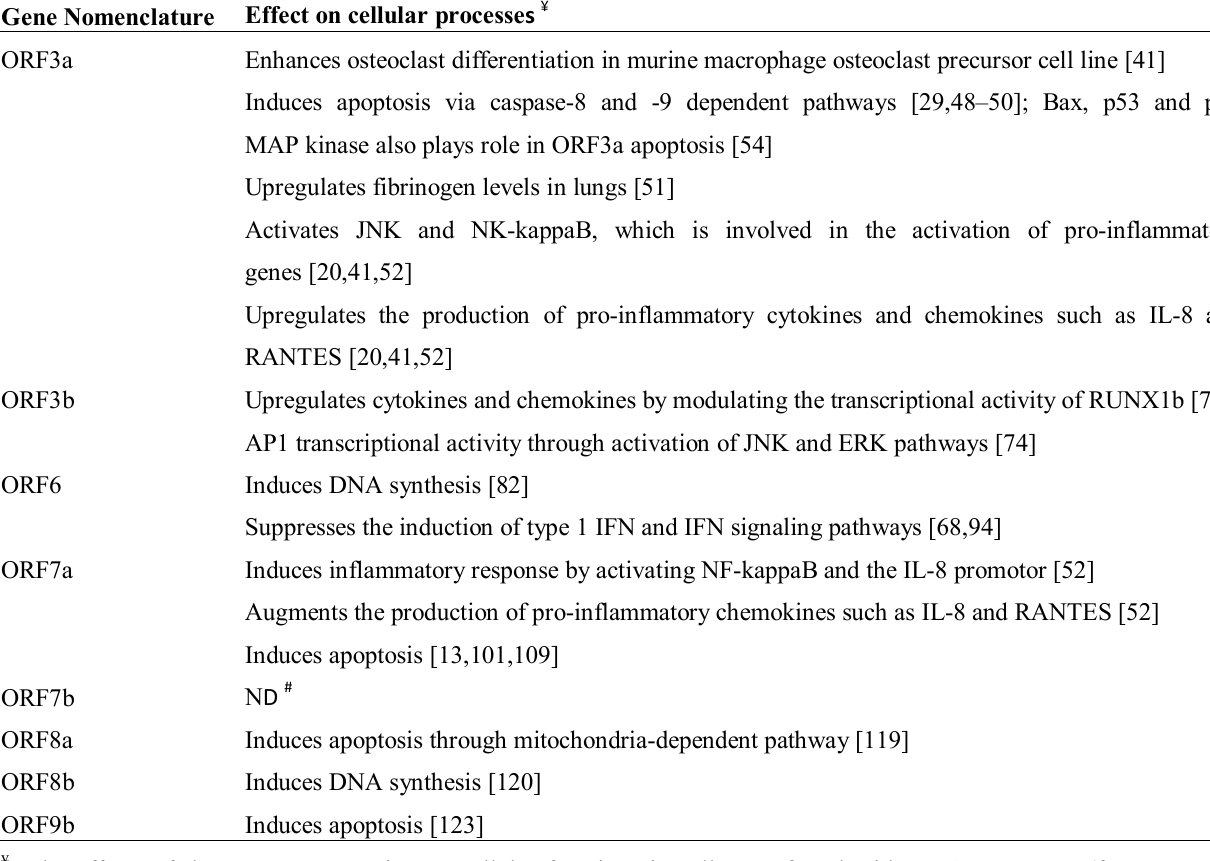
1. Summary of the effects of the SARS-CoV accessory proteins on cellular